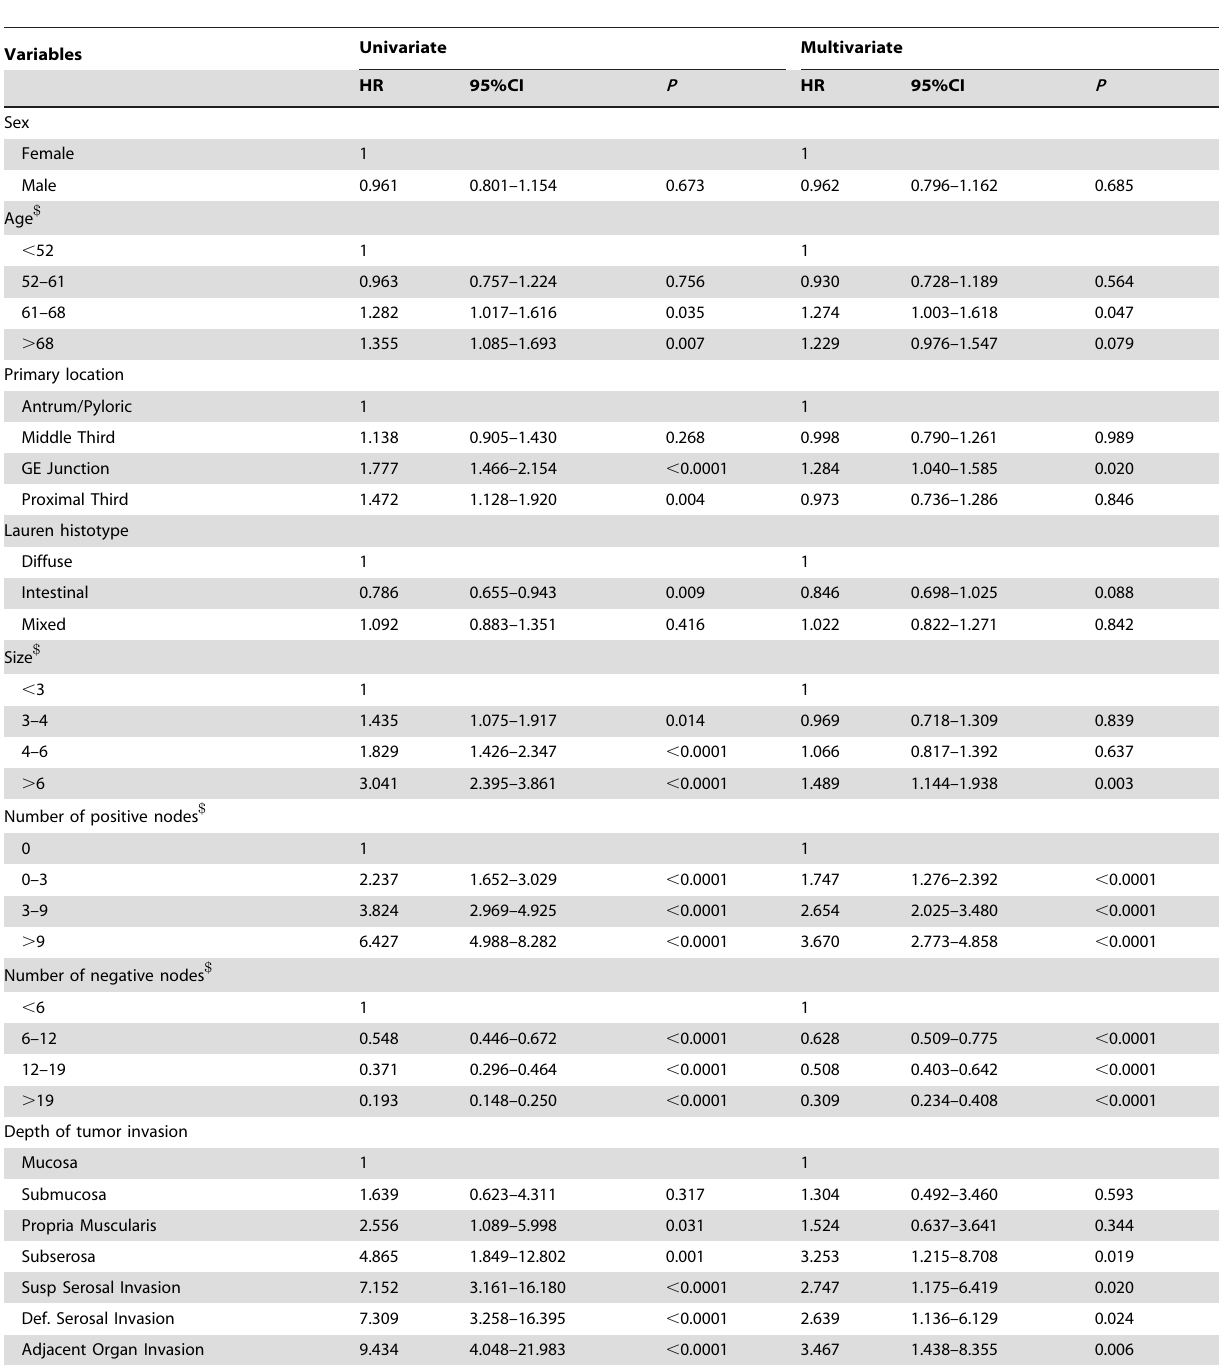
Table 2. Univariate and multivariate analysis of clinicopathologic variable influence on DSS in Chinese